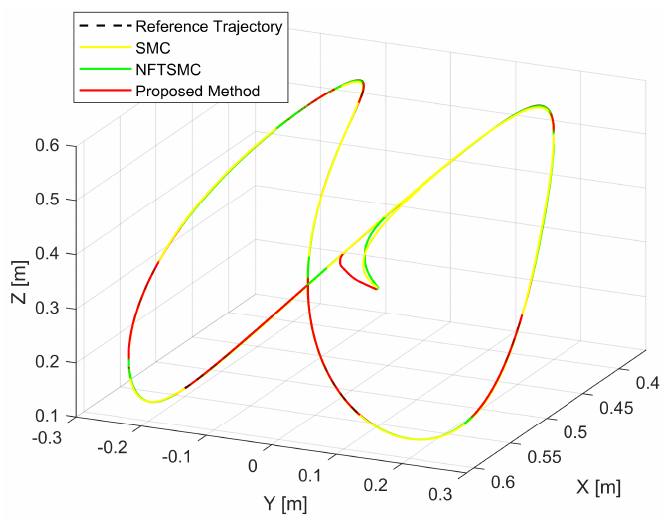
Figure 5. The desired trajectory and the real trajectory of the robot’s